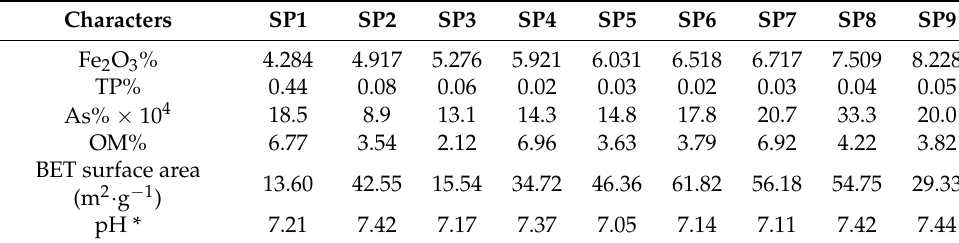
Table 2. Properties of the collected actual soil.